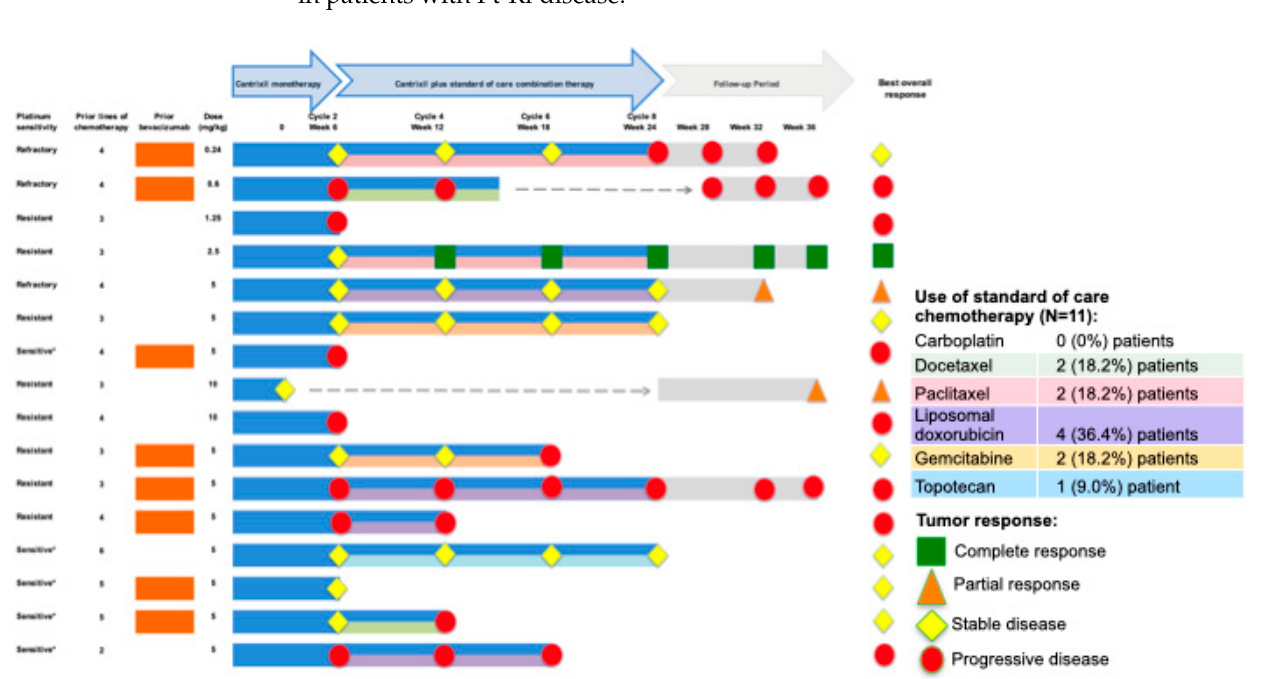
Figure 4. Swimmer plot showing duration of therapy, combination therapy regime, and disease response based on RECIST Version 1.1 criteria for each patient. * Patients who were unable to receive further platinum-based chemotherapy due to documented intolerance.